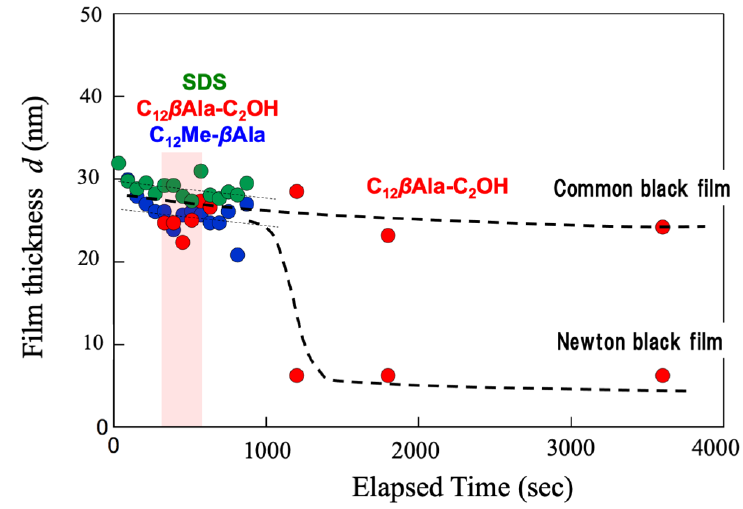
Figure 14. Time–dependence of film thickness ( d ) determined by q -crossover from q − 2 to q − 4 in coherent SANS, obtained for SDS, C 12 –EtOH– β Ala, and C 12 –Me– β Ala. For SDS (green), d = 29 nm appeared at the start and gradually decreased, whereas for C 12 –EtOH– β Ala and C 12 –Me– β Ala (red and blue), d = 27 nm was common at the start. For C 12 –EtOH– β Ala, d was constant, and after 1000 s it split into two; the thick one was a common black film, and the thin one (obtained in Figure 12b) was a Newton black film. The time domain at 300–480 s is indicated in red. Broken lines are guides for the eye.